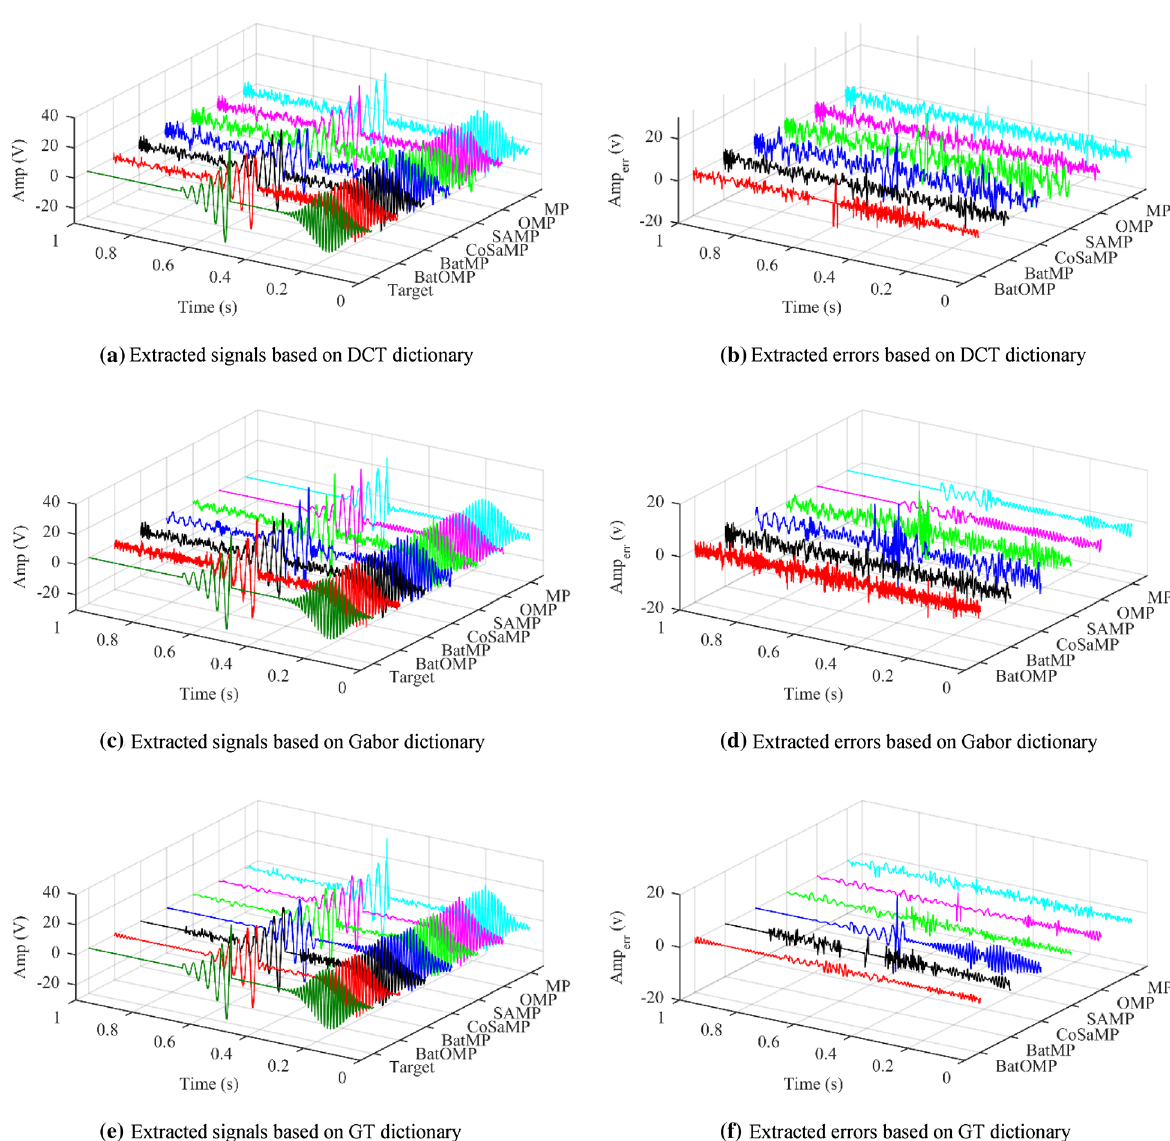
Figure 9. Signal extraction results. Colors: jasper: the target signal s ; red: result of BatOMP; black: result of BatMP; bule: result of CoSaMP; green: result of SAMP; pink: result of OMP; skyblue: result of